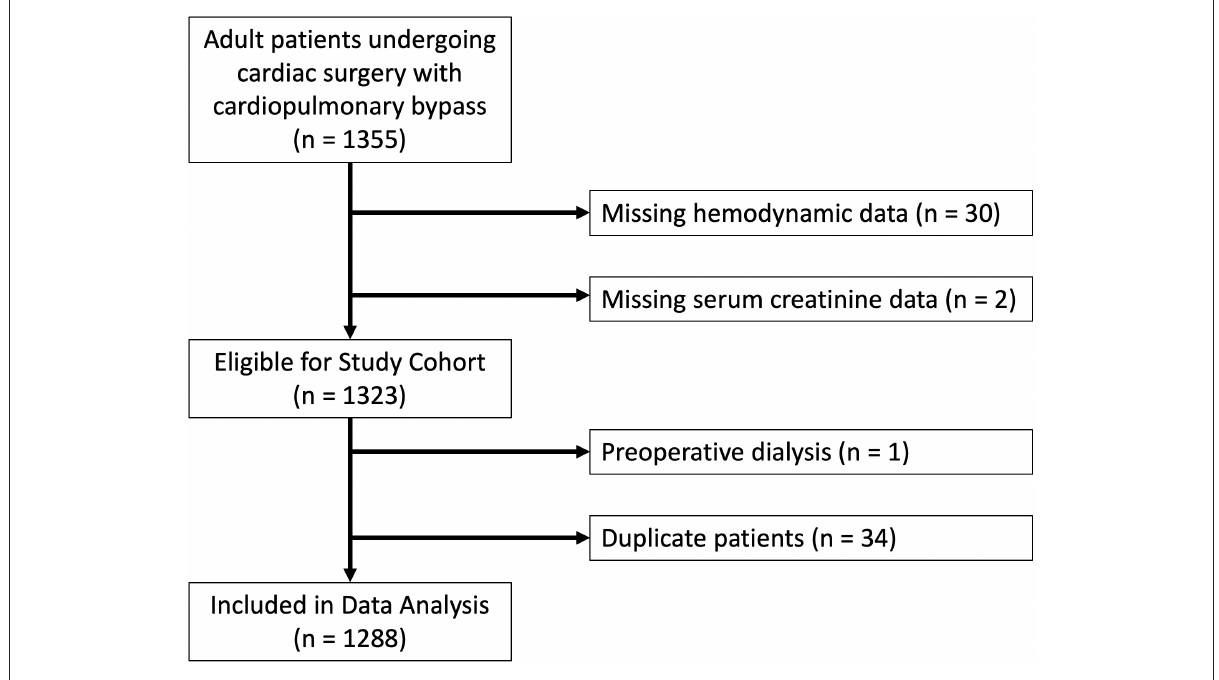
FIGURE1 Flowchart of study design with reasons for exclusion for patients excluded from final